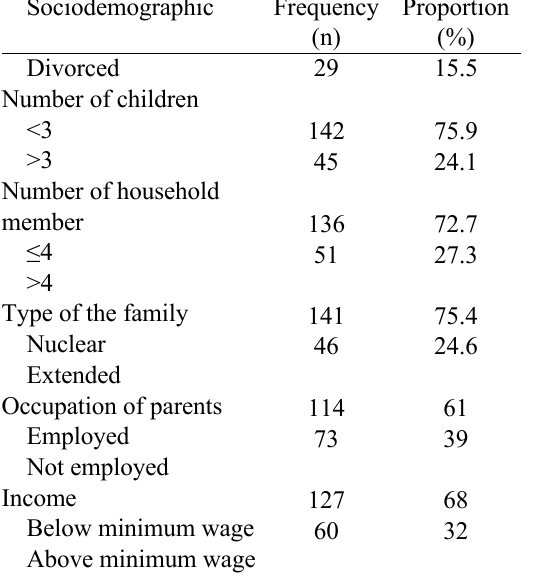
Table 2. Distribution of dietary diversity, social assistance, coping strategy, and food